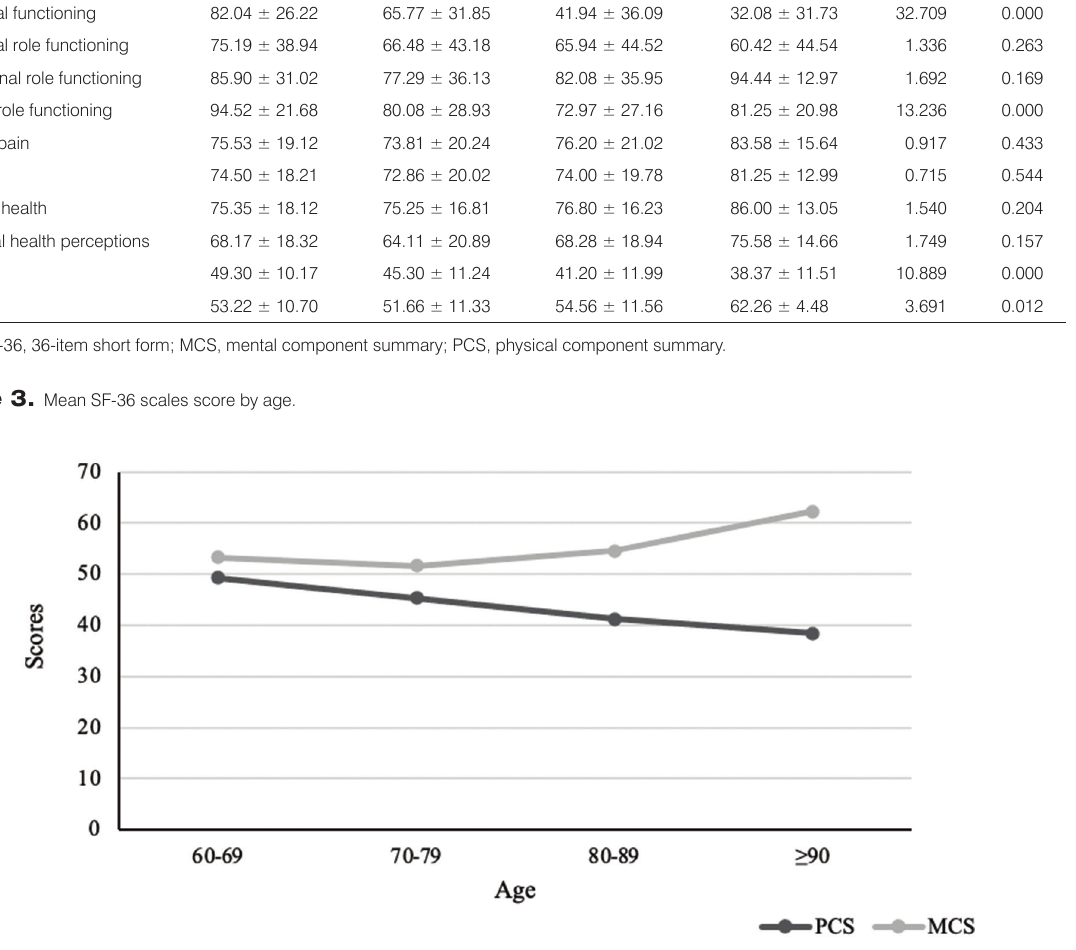
Figure 1. The difference in PCS and MCS of SF-36 in 313 older adults by age group.